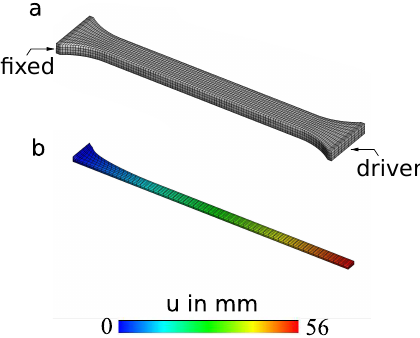
Figure 6. Finite element model for Sylgard 184 silicone elastomer: ( a ) discretization and boundary conditions for a DIN EN ISO 527-2 1A specimen and ( b ) simulation of the tensile test. The contour shows the longitudinal